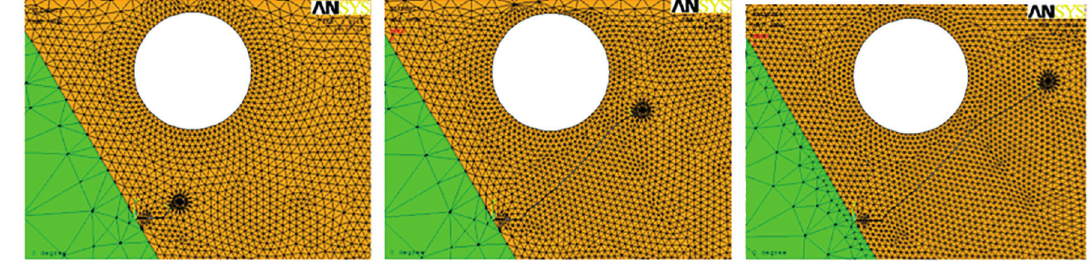
Figure 13: Three steps of crack propagation predicted by GF criterion (Cavity effect).